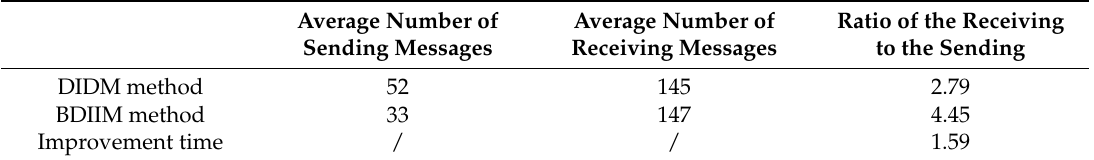
Table 8. Energy cost and position estimation error of the nodes in